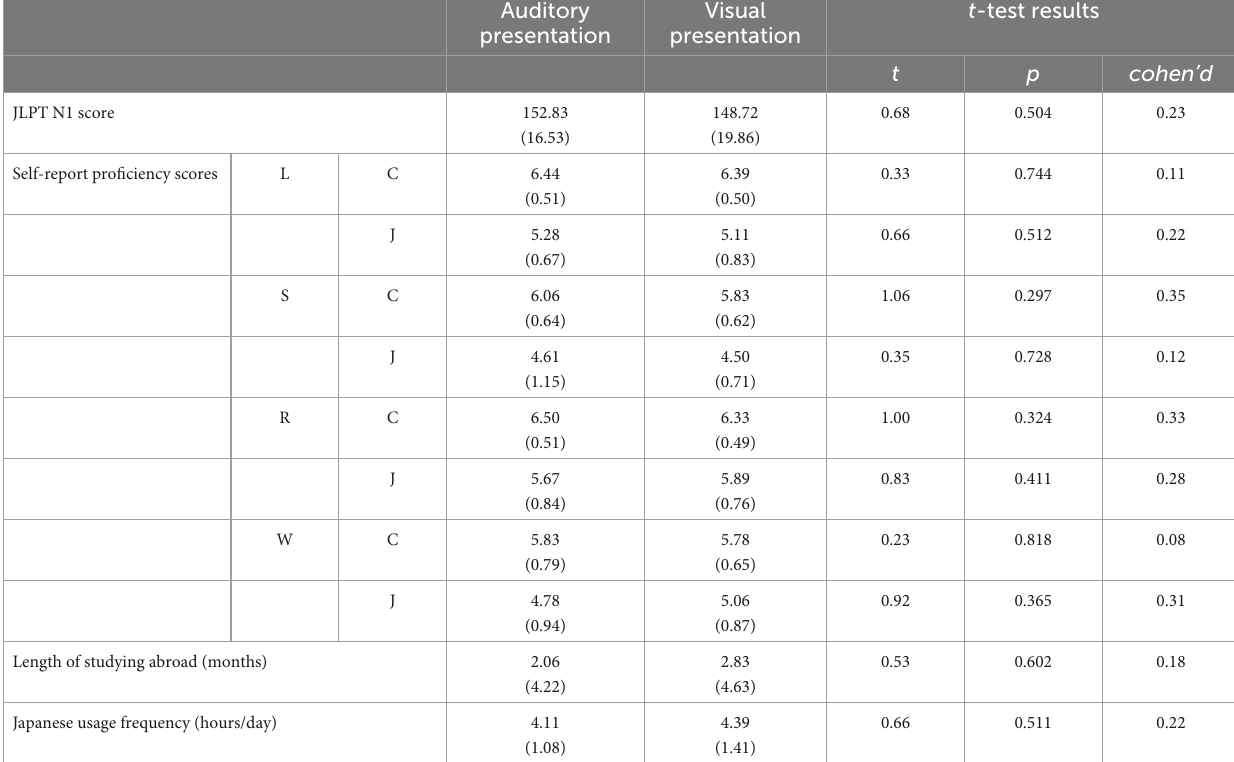
TABLE 1 Participants’ language proficiency, Japanese usage frequency, and comparisons of different presentation